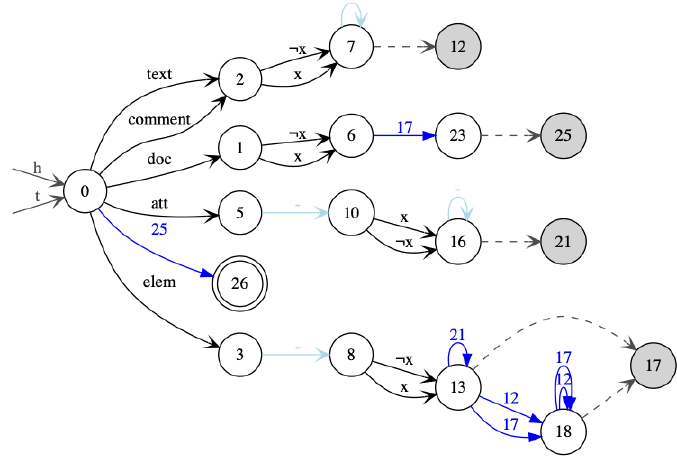
Figure 24. Nested words of x -marked XML documents.